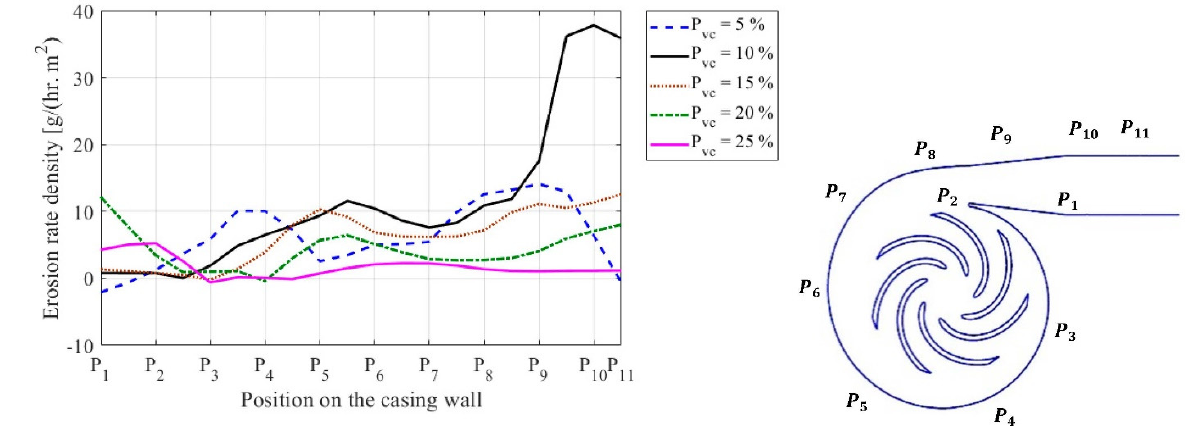
Figure 22. Erosion density rate distribution for different concentrations of particles under the cavitation conditions.